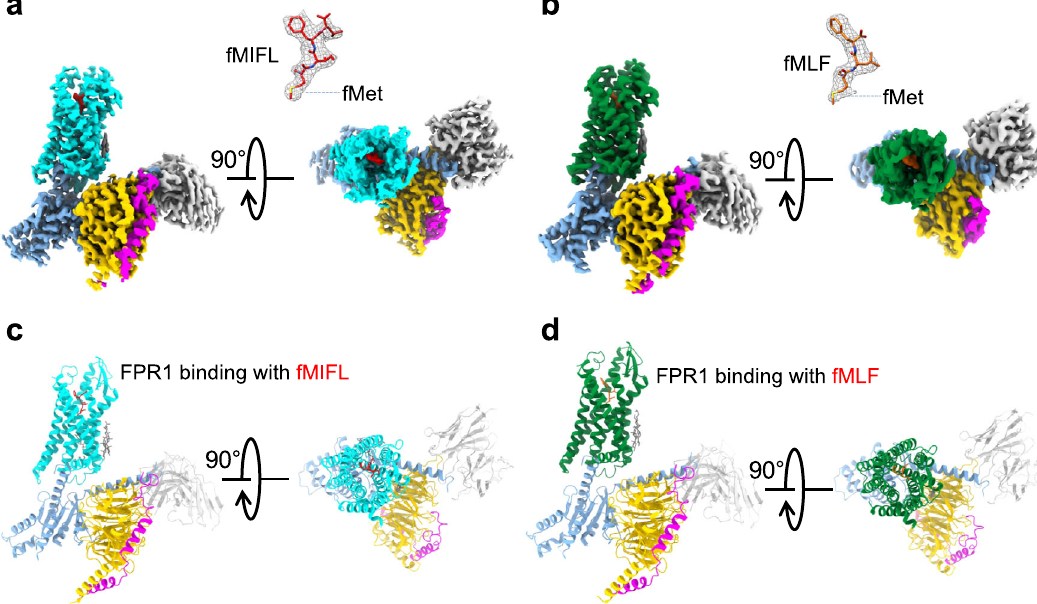
Fig. 1 | EM density map and overall structure of FPR1-Gi-scFv16 bound to N-formylpeptides.a,b Sideviewandextracellularviewofthe3Dcryo-EMdensity map of FPR1-Gi-scFv16 bound to fMIFL ( a ) and fMLF ( b ). The position of the N-terminal fMet is marked (insets). c , d Side view and extracellular view of the